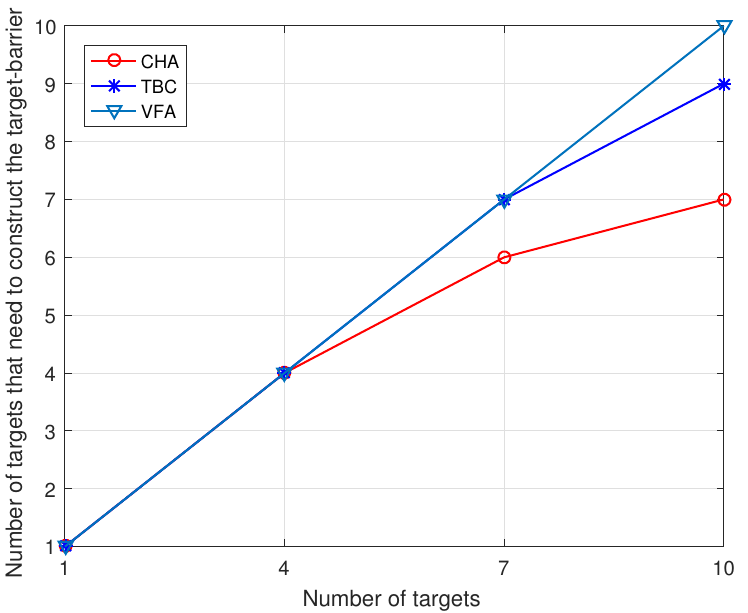
Figure 2. Number of targets that need to construct the target-barrier versus Number of targets.